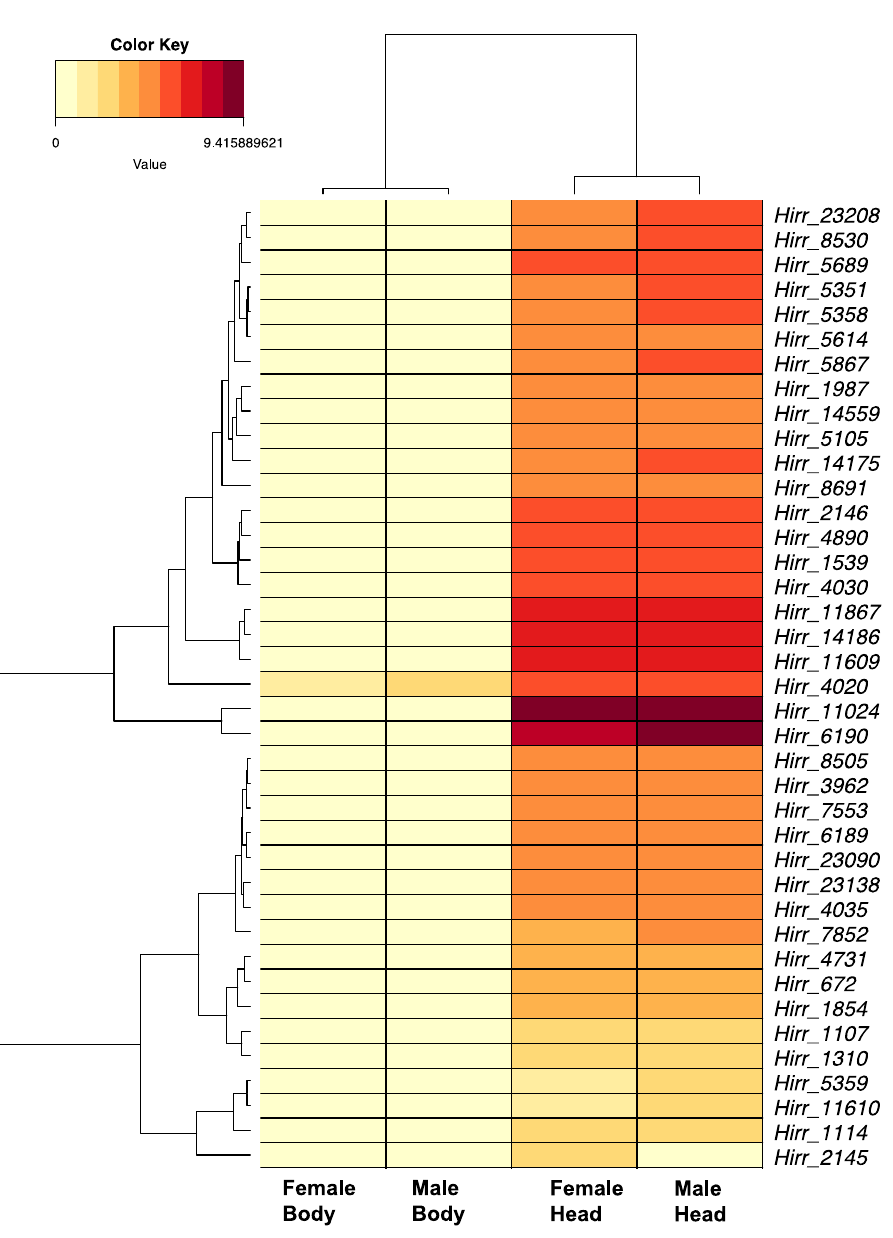
Figure 7. Heat map and hierarchical clustering dendrogram of Haematobia irritans candidate OR transcripts in female and male head appendages (Head) and headless bodies (Body). Log-transformed TPM values were used to construct the heat map. Five candidate OR transcripts are not depicted, as they had low levels of expression. Dendrogram reflects transcripts with similar expression patterns, identified by hierarchical clustering applied to expression values (rows) and dataset categories (columns).